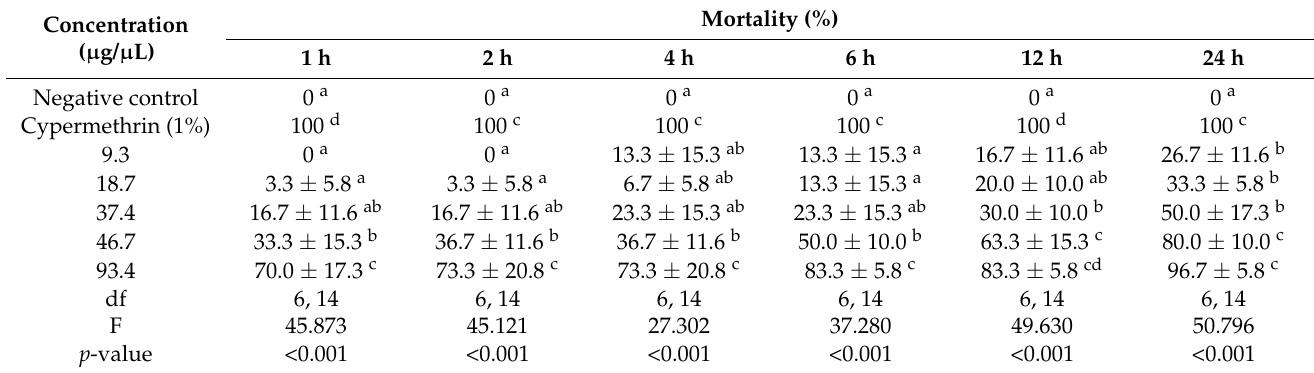
Table 1. Percent mortality (mean ± SD) of insecticidal activity of Plectranthus amboinicus essential oil against Stomoxys calcitrans by contact toxicity test at different concentrations.